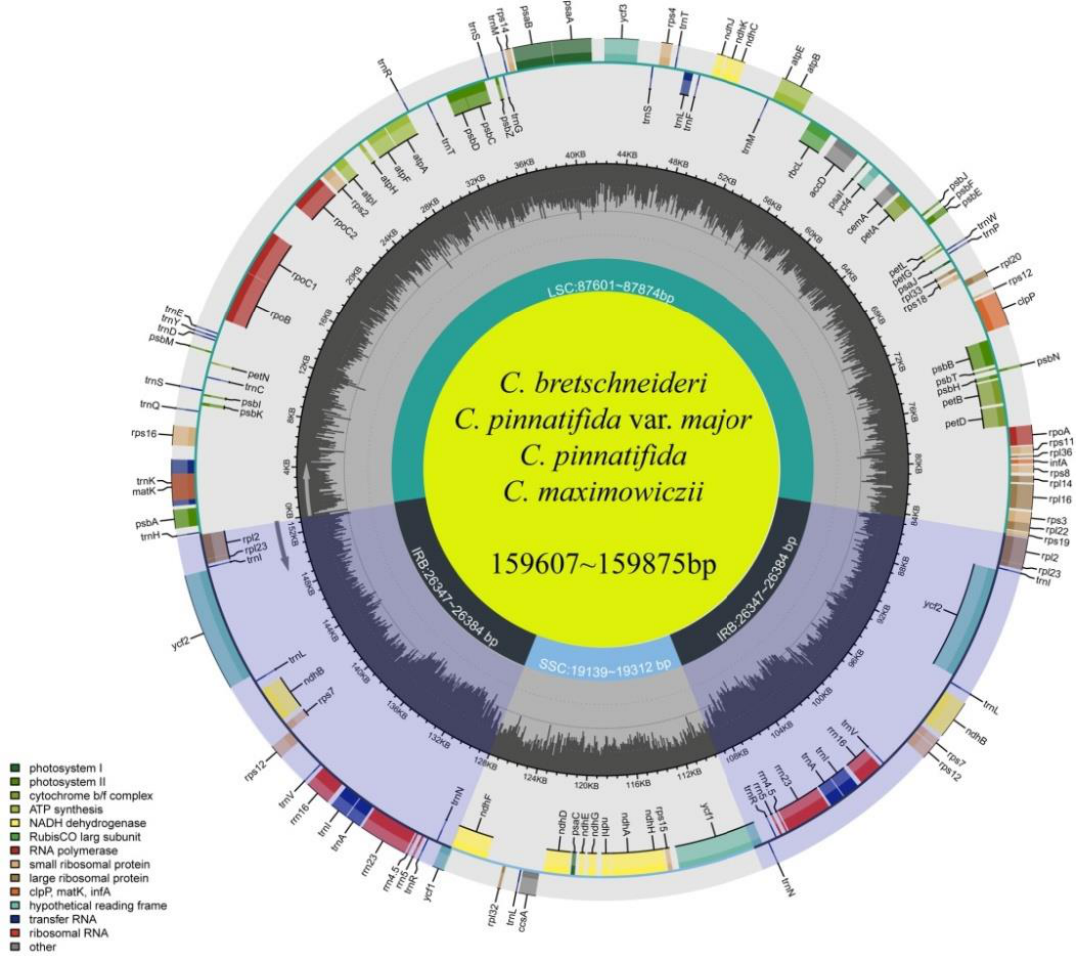
Figure 1. Gene map of four Crataegus ( C. bretschneideri , C. pinnatifida var. major , C. pinnatifida , and C. maximowiczii ) chloroplast genomes. Genes drawn outside circle are transcribed clockwise, while the genes inside the circle are transcribed counterclockwise. The colored bars represent genes of different functional groups. The darker gray color in the inner circle corresponds the GC content of the plastomes. Table 2. Elemental characteristics of four Crataegus chloroplast genomes. Characteristics